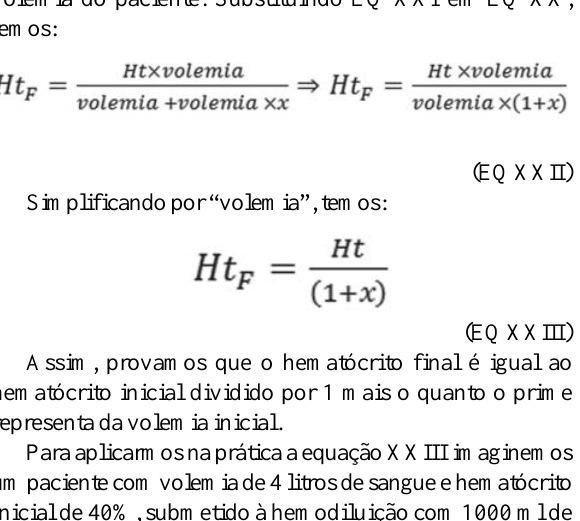
Fig. 6 - Alterações de fluxo, quando este passa de laminar a turbulento. Retirado de Silva Jr MR. Fisiologia da circulação. 2ª ed. São Paulo:Edart;1977.